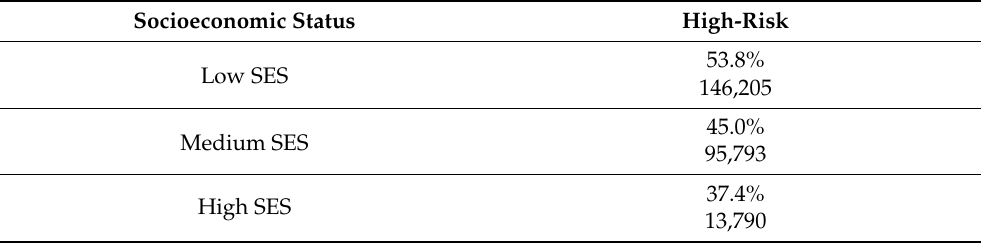
Table 5. Hispanics with High-Risk Pre-Existing Health Conditions by Socioeconomic Status. Socioeconomic Status High-Risk Low